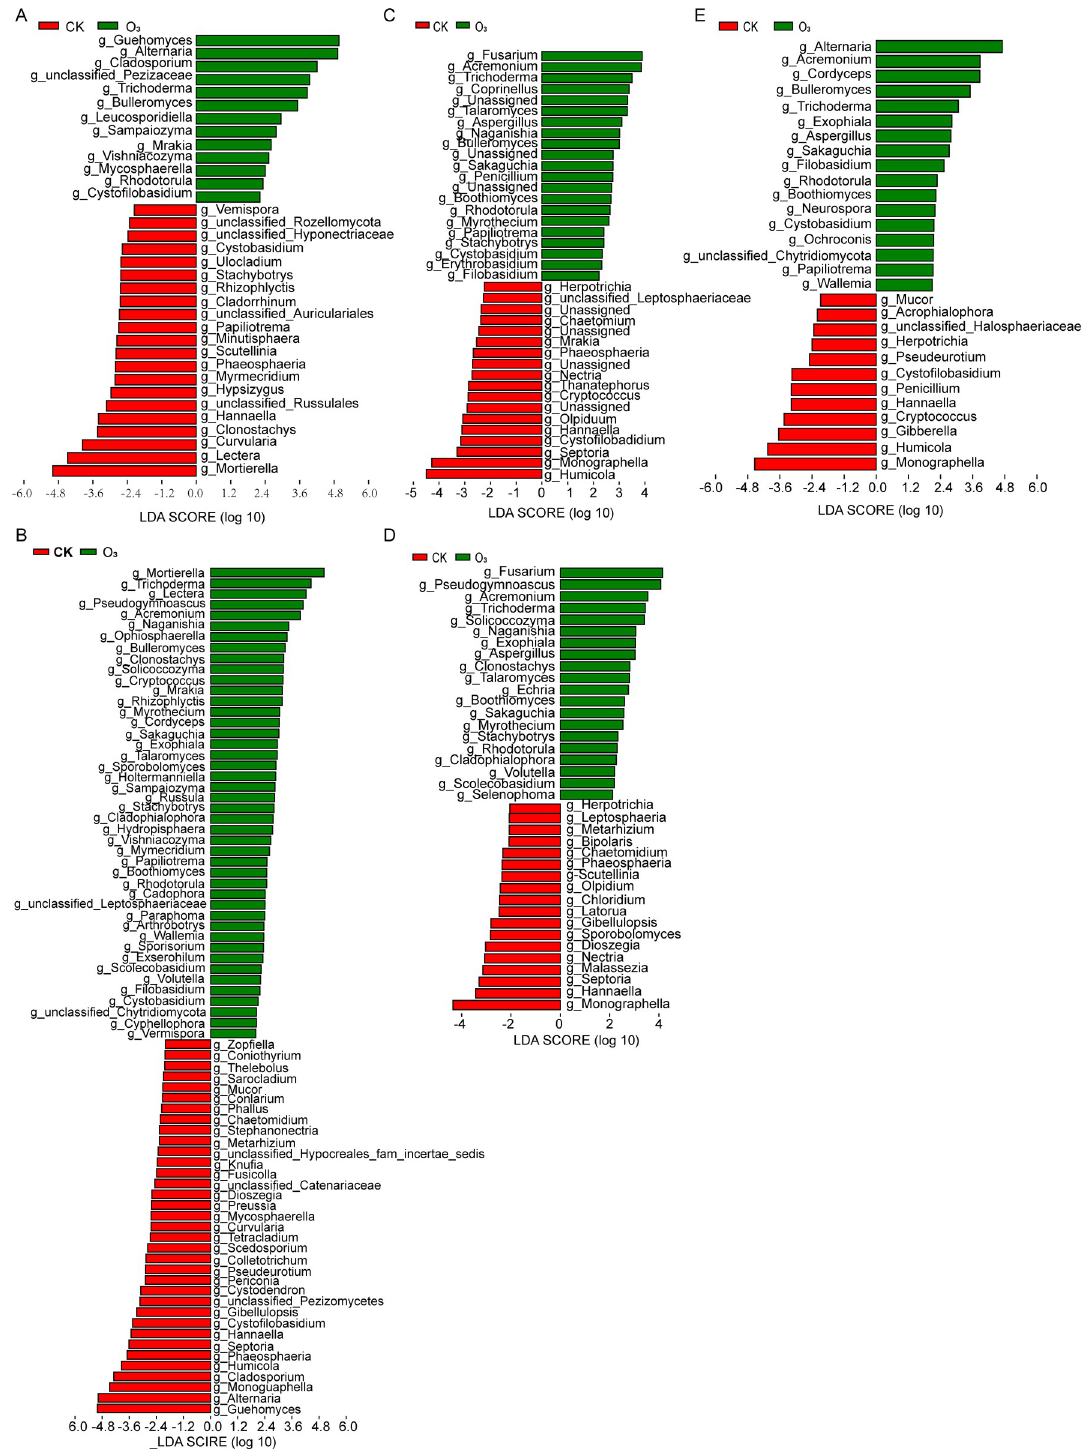
Fig 4. Significantly differential biomarkers between CK group and O 3 group at various days were analyzed using LEFSe. (A-E) Differential biomarkers at 0, 1, 3, 5 and 9 days. Statistical significance: � p < 0.05, �� p < 0.01, ��� p < 0.001, ���� p < 0.0001.